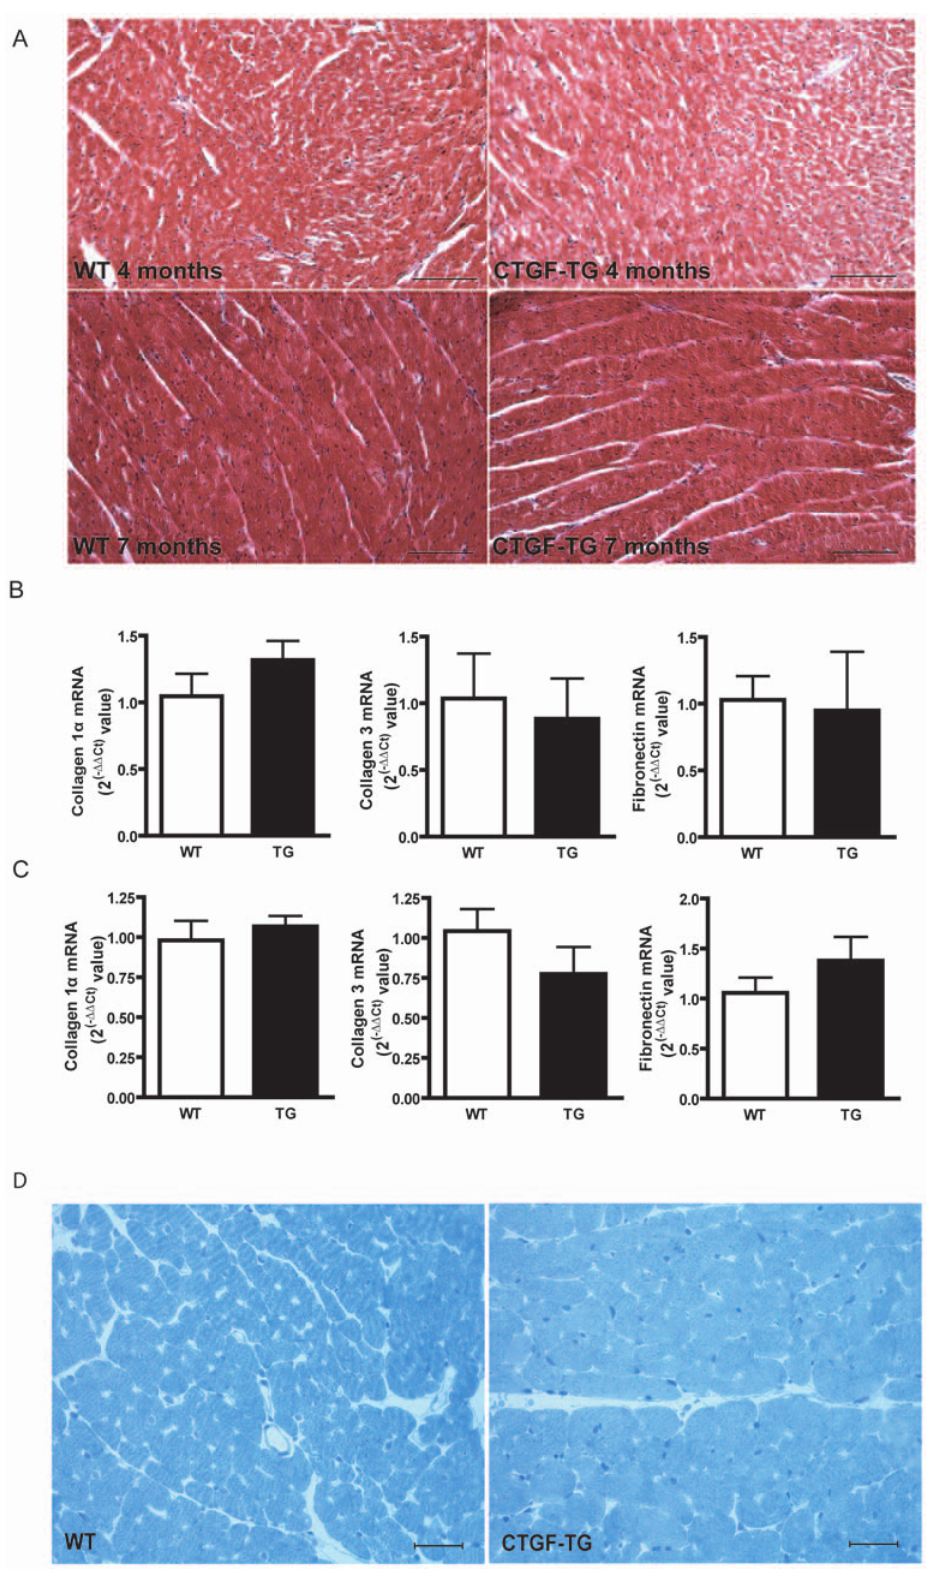
Figure 3. Assessment of cardiac fibrosis at age of 4 and 7 months in CTGF-TG and WT mice. (A) Masson’s trichrome stained cardiac sections of WT and CTGF-TG mice at age of 4 and 7 months. Scale bars designate a length of 100 m m. (B, C) Quantification of the collagen 1 a , collagen 3 and fibronectin mRNA expression by TaqMan-PCR performed at age of 4- (B) and 7 months (C) (n=4 per group). (D) High magnifications of toluidine blue- stained semithin sections, with myofiber hypertrophy apparent in 7 months old CTGF-TG hearts. Scale bars designate a length of 20 m m.